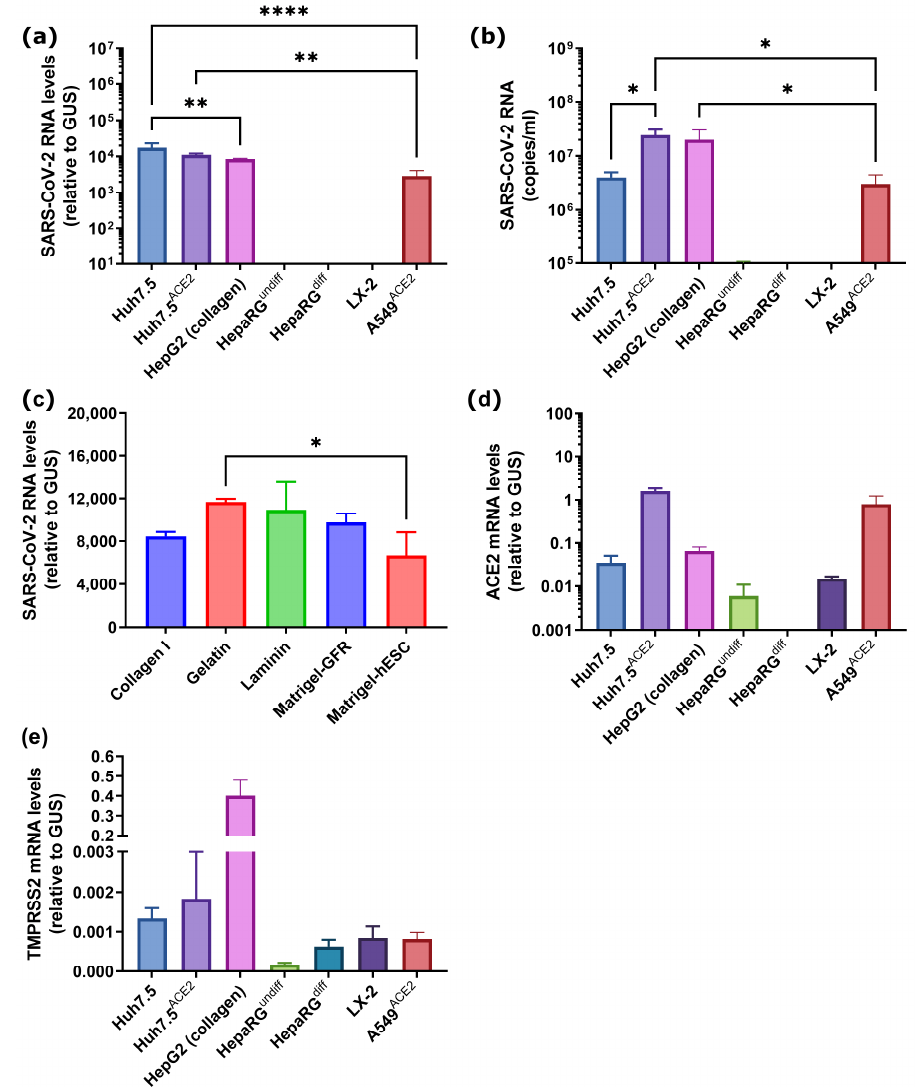
Figure 2. SARS-CoV-2 establishes productive infection in human hepatoma but not in non- transformed hepatocyte-like cells or hepatic stellate cells. Cells were seeded on standard ( a , b ) or coated ( c , d ) cultured plates (HepG2 cells), incubated with SARS-CoV-2 at a MOI of 0.1 for 2 h, and levels of the virus RNA in cells ( a , c ) or conditioned medium ( b , d ) were quantified by RT-qPCR 4 days later. ( e , f ,) Levels of ACE2 ( e ) or TMPRSS2 ( f ) mRNA in cells presented on panel ( a ). The values are the means ± standard deviation (S.D.). * p < 0.05, ** p < 0.01, **** p <